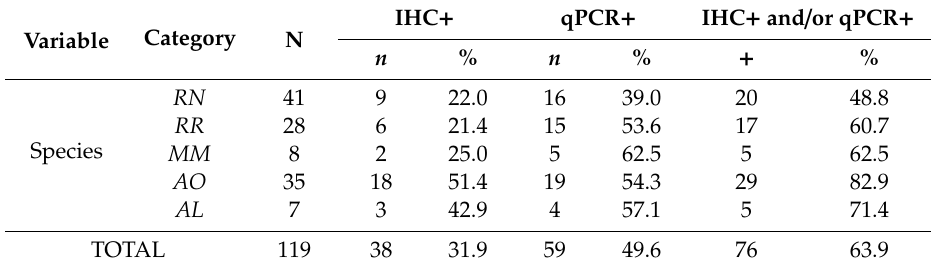
Table 3. Detection of pathogenic Leptospira by immunohistochemistry (IHC), real-time polymerase chain reaction (qPCR), and IHC plus qPCR in rodents from di ff erent species trapped in dairy farms in the Los R í os Region, Chile.